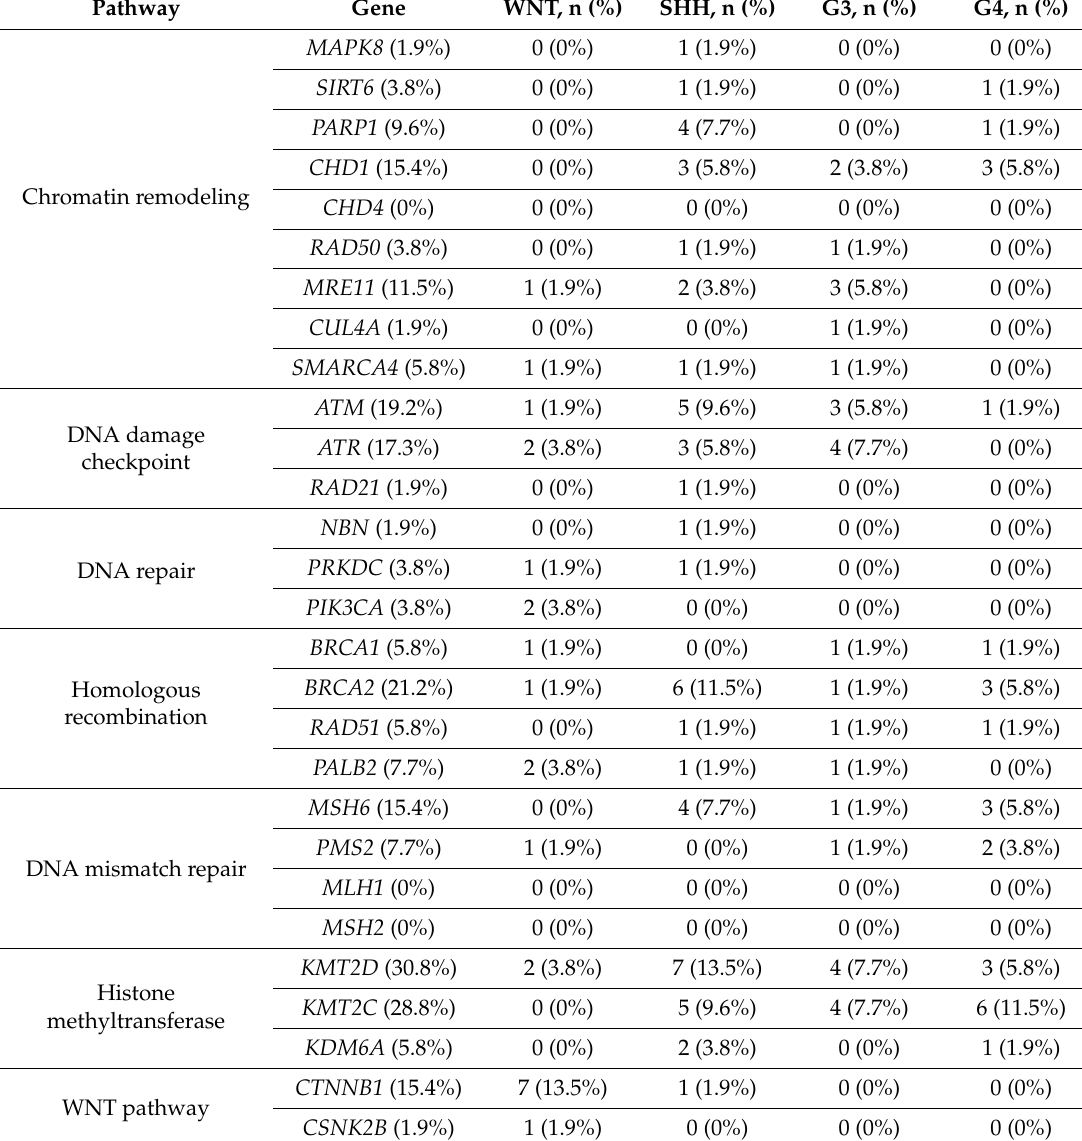
Table 3. Prevalence and subgroup distribution of the 46 somatic mutations identified based on RNA-Seq from a selected panel of 51 genes in a cohort series of 52 childhood MBs in